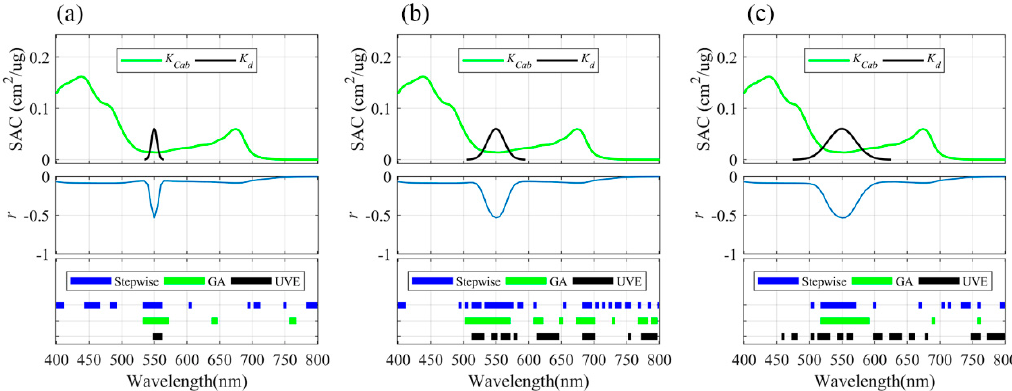
Figure 3. Bands selected in PLSR models with three different variable selection/elimination approaches to estimate C d with different absorption half-widths: ( a ) 10 nm, ( b ) 30 nm, and ( c ) 50 nm. The locations of absorption peaks and absorption intensities were set to 550 nm and 0.06 cm 2 /ug, respectively.